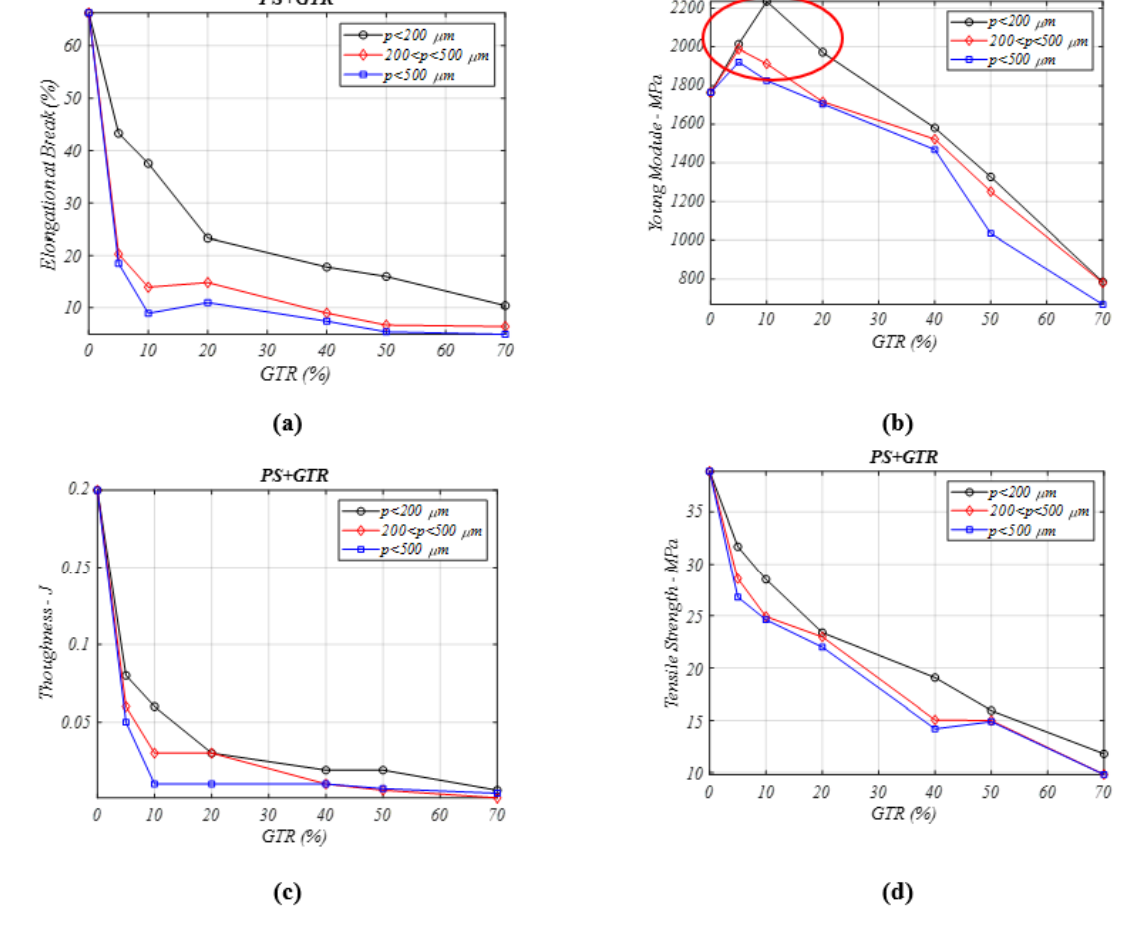
Figure 7. Mechanical properties analysis for different percentages of PS/GTR composites and particle diameters: ( a ) elongation at break (%), ( b ) Young’s modulus (MPa), ( c ) toughness (J) ( d ) tensile stress (MPa).